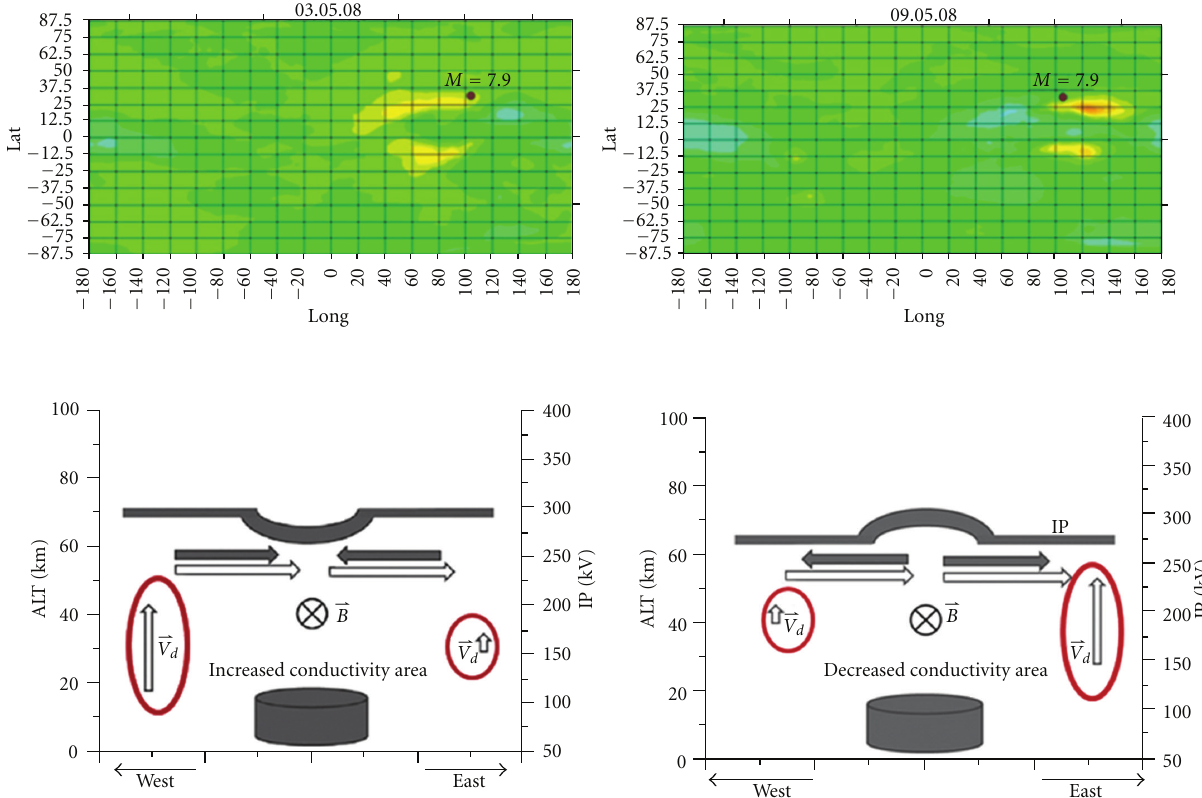
Figure 10: Bottom panel: schematic conception of atmosphere-ionosphere coupling through the global electric circuit: left panel: for condition of increased air conductivity, right panel: for condition of decreased air conductivity. Upper panel: the di ff erential maps obtained from the GIM GPS TEC data for the period before the Wenchuan earthquake on 12 May 2008. Left panel: 2D distribution obtained on 3 of May 2008, right panel: 2D distribution obtained on 9 May